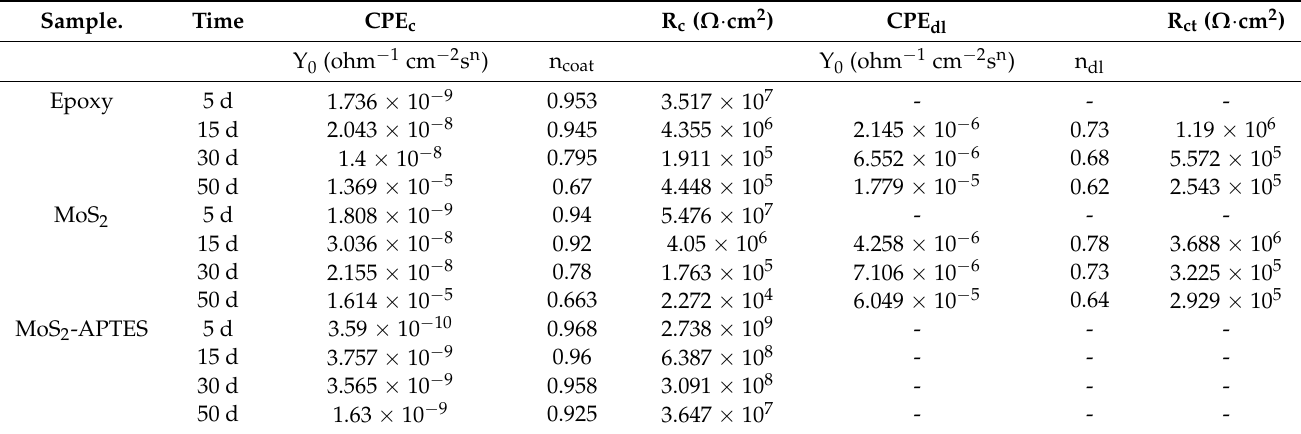
Table 1. Electrochemical impedance data of neat and composite waterborne epoxy coatings. Sample.